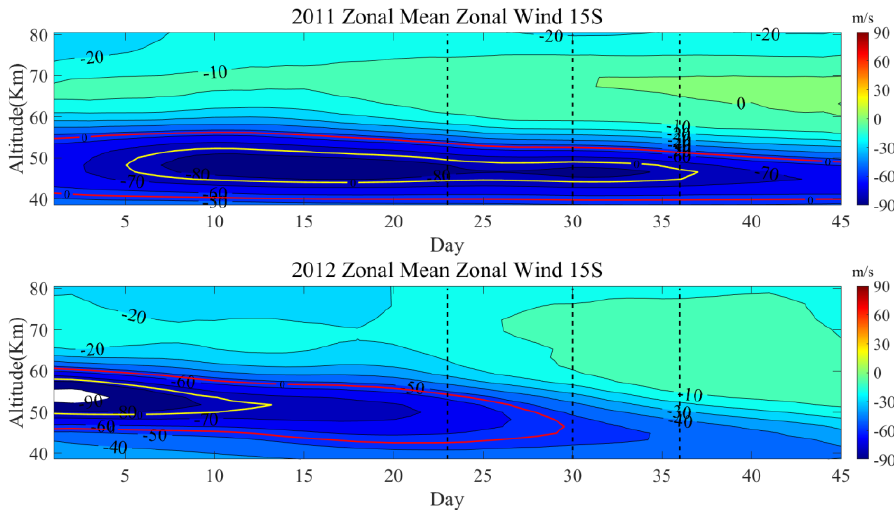
Figure 6. MERRA − 2 mean zonal winds at 15° S during January and February ( up ) 2011 and ( down ) 2012. The contour intervals are 10 m/s. The vertical dot lines are the same as in Figure 2. The bold red (yellow) line is the critical level of W4 (W3) where the mean zonal wind matches the wave phase speed.